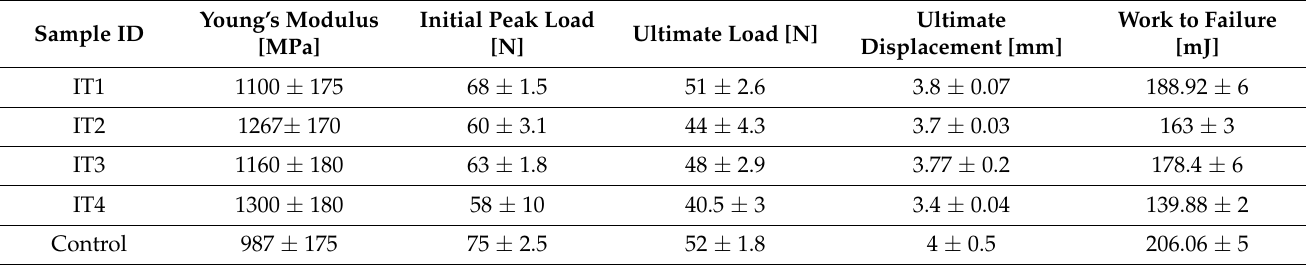
Table 6. Mechanical properties of the retrieved and control samples after the small punch